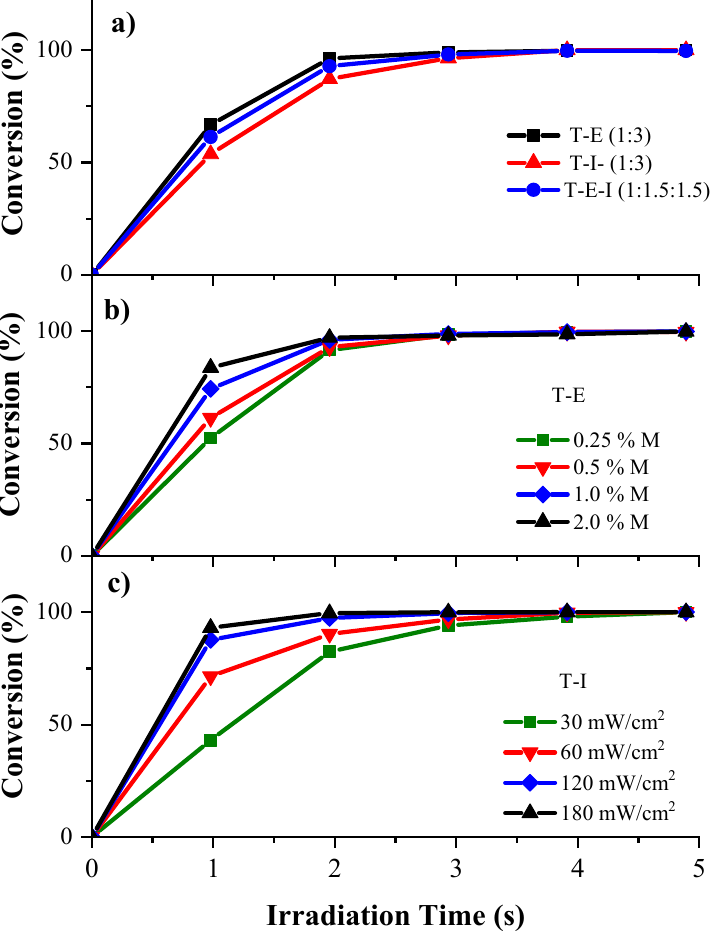
Figure 2. Kinetics of photopolymerization of pristine acrylates using the RT-FTIR technique: ( a ) comparison of the reactivity of the formulations T–E (1:3), T–I (1:3) and T–E–I (1:1.5:1.5), at 0.5 mol% of DMPA and 0.5 mol% of BAPO at 30 mW/cm 2 of UV-Vis light intensity; ( b ) effect of the concentration of the mixture of photoinitiators DMPA:BAPO on T–E formulation at 60 mW/cm 2 ; ( c ) effect of the UV-Vis light intensity on the photopolymerization rate of the formulation T–I at 0.5% mol of photoinitiators. All three formulations displayed a very rapid photopolymerization, achieving con- versions of 90% in 2 s, when irradiated with UV light intensity of 30 mW/cm 2 and a concentration of 0.5 mol% of both, BAPO and DMPA. A quantitative conversion was accomplished after 3 s in all cases. The formulation T–E (1:3) displayed a higher pho- topolymerization rate than the formulation T–I (1:3) while the formulation T–E–I